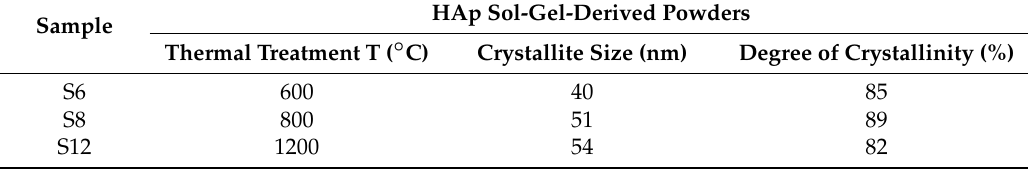
Table 1. Crystallite size and degree of crystallinity of the sol-gel-derived powders thermally treated at different temperatures.